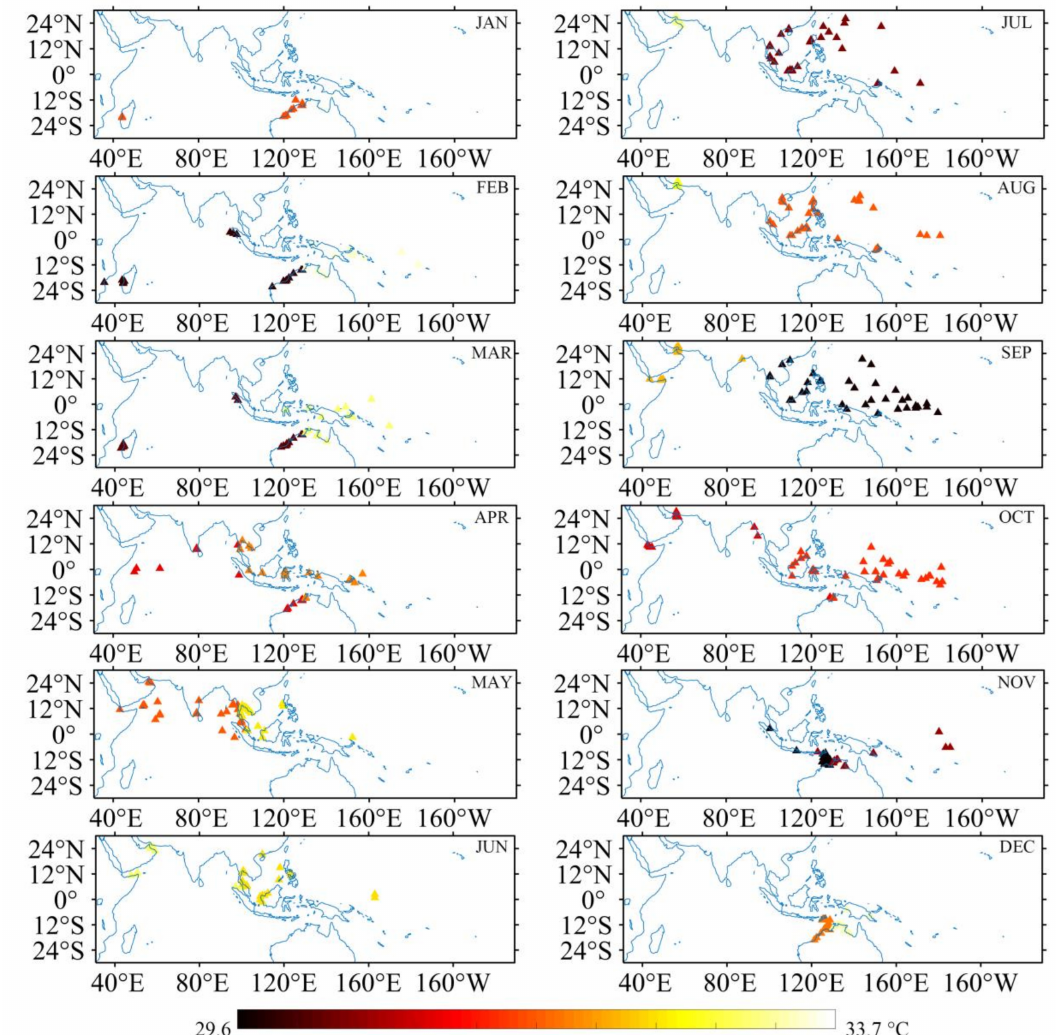
Figure 6. Maximum SST locations of both the IW and the PW in the calendar